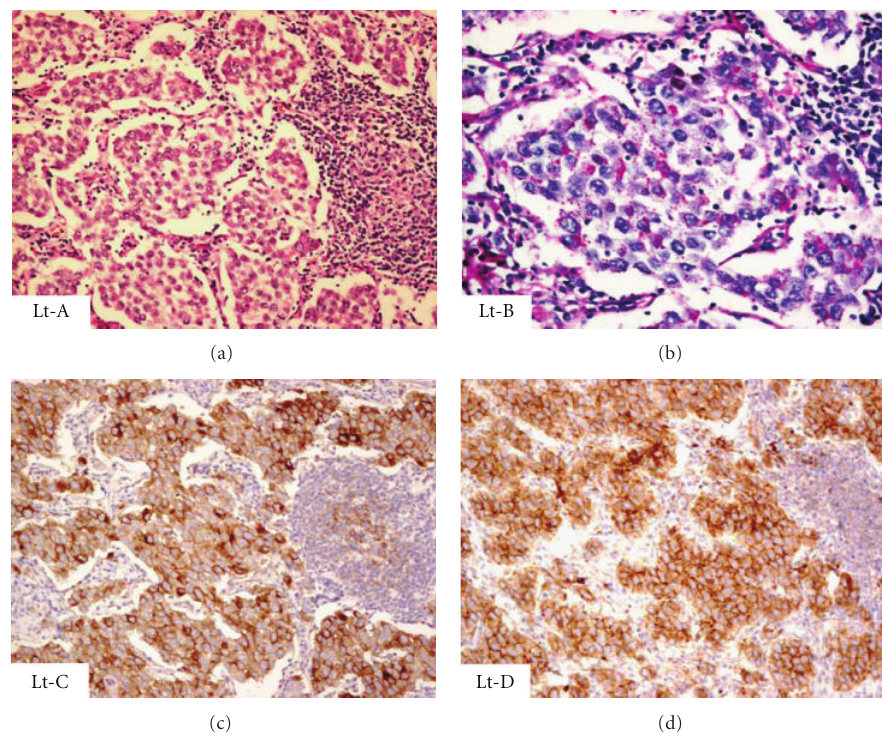
Figure 2: Histology of the left gonad (Lt). (a) classical seminoma, with tumor cells with nests, anastomosing cords, and sheets, ill-formed tubular growth pattern, accompanied by a heavy lymphocytic infiltrate, H&E × 100. (b) Large polygonal tumor cells, with glycogen-rich clear cytoplasm, PAS × 200. (c) Tumor cells are immunoreactive to both placental alkaline phosphatase and to C-Kit (d), both ×